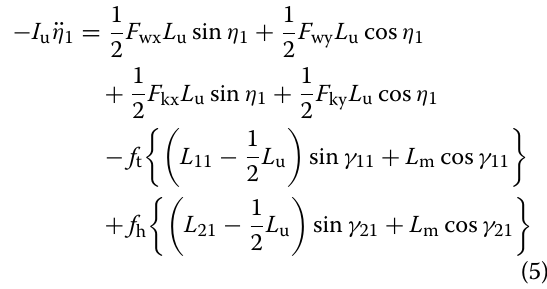
Table 2 Properties of the MPA used in this study Length of MPA (when pressure is not input) 250 mm Weight of MPA (when pressure is not input) 41.4